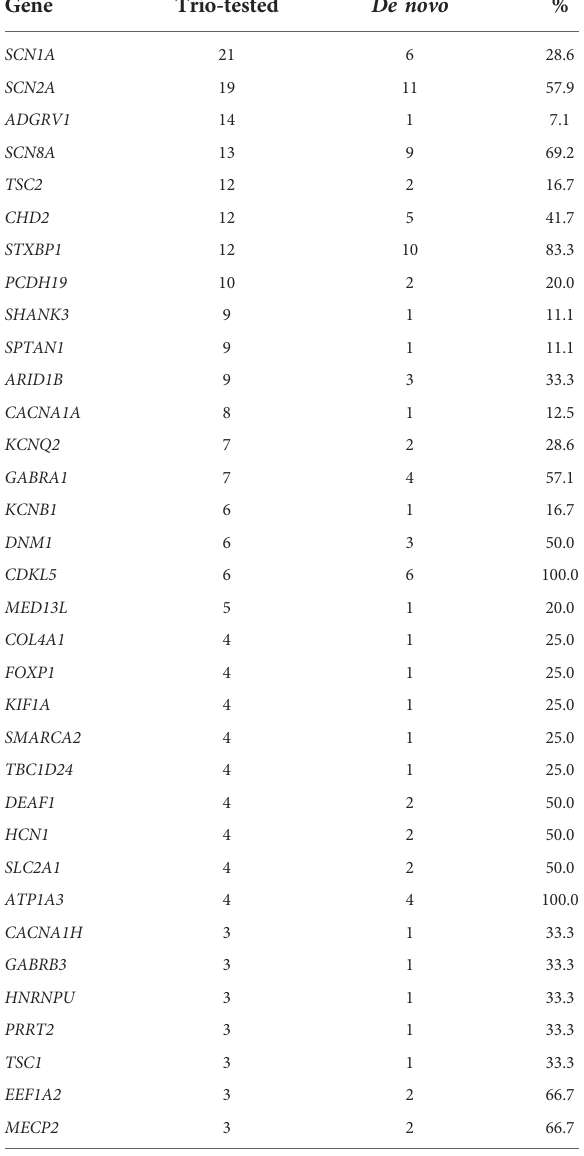
TABLE 3 Trio-tested genes and the number of de novo variants